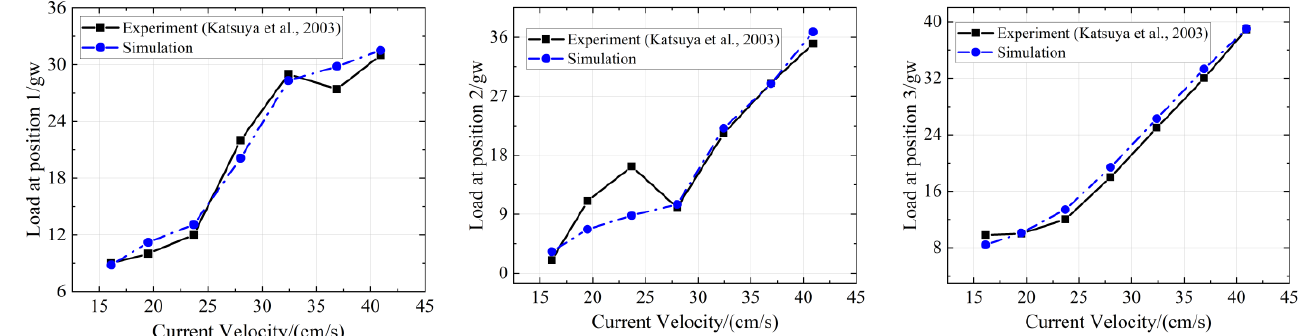
Figure 11. The comparison of the tension loads of net type C [36].